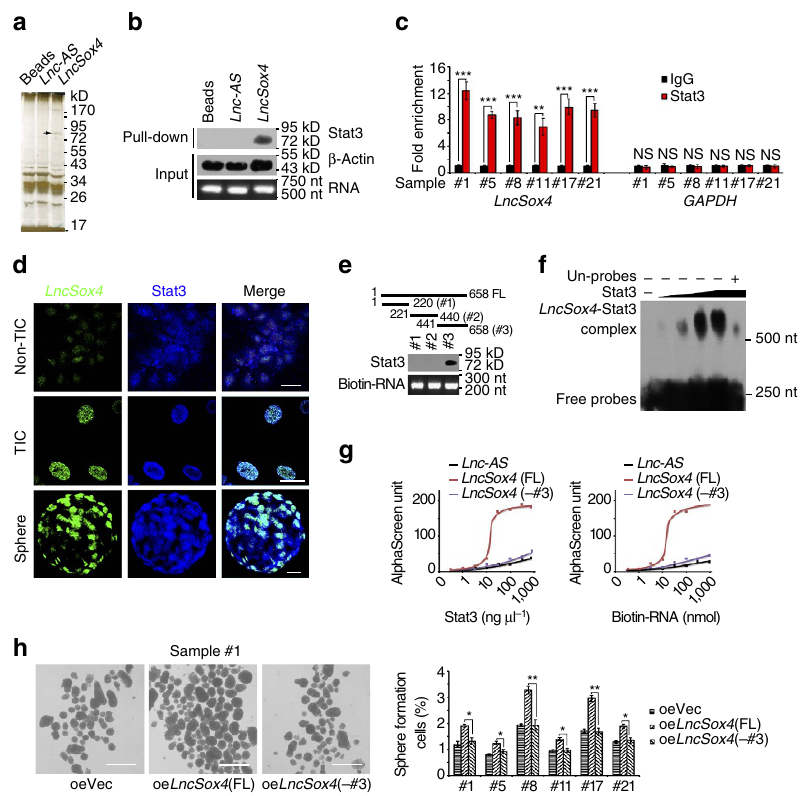
Figure 4 | LncSox4 interacts with Stat3. ( a ) RNA pull-down assay was performed using LncSox4 , Lnc-AS ( LncSox4 antisense RNA) and control RNA, and the samples were separated by Coomassie staining, followed by identification using mass spectrum. The black arrow indicates Stat3. KD, kiloDalton. ( b ) The interaction between LncSox4 and Stat3 was confirmed by RNA pull-down and western blot. Lnc-AS, LncSox4 anti-sense. b -Actin served as loading controls. ( c ) RIP was performed using anti-Stat3 and control IgG antibodies, followed by real-time PCR to examine the enrichment of LncSox4 and GAPDH. GAPDH served as a negative control. ( d ) LncSox4 is co-localized with Stat3. LncSox4 probes and anti-Stat3 antibody were used to examine the subcellular location using flow cytometer sorted CD133 - (Non-TIC), CD133 þ (TIC) cells and stem-like oncospheres (Sphere). Scale bars, 10 m m. ( e ) Three regions of LncSox4 were examined for interaction with Stat3. The indicated truncates of LncSox4 were constructed and RNA pull-down assays were performed. The samples were examined by western blot with anti-Stat3 antibody. ( f ) LncSox4 interacts with Stat3. Biotin-labelled LncSox4 was obtained by in vitro transcription assays and incubated with recombination Stat3 protein, followed by RNA EMSA. 100 (cid:2) unlabelled probes were used for competitive EMSA. ( g ) Bead-based proximity assay of LncSox4 , LncSox4 truncate (-#3 region) and LncSox4 -antisense (Lnc-AS ) (50nnol) were incubated with various concentrations (horizontal axis) of Stat3 (left) or Stat3 (50ng m l (cid:3) 1 ) mixed with various concentrations (horizontal axis) of biotin-labelled RNA (right); and units generated by the assay system were shown. ( h ) LncSox4 (FL), LncSox4 truncate (-#3 region) overexpressing primary HCC cells were established, followed by sphere-formation assay. Typical spheres were shown in left panels, and sphere formation ratios in right panels. Scale bars, 500 m m. Data were shown as means ± s.d. Two-tailed Student’s t -test was used for statistical analysis. * P o 0.05; ** P o 0.01; *** P o 0.001. P o 0.05 was considered significant. Data are representative of four independent experiments. For b , e and f , the original images are shown in Supplementary Fig. 6. NS, not significant.